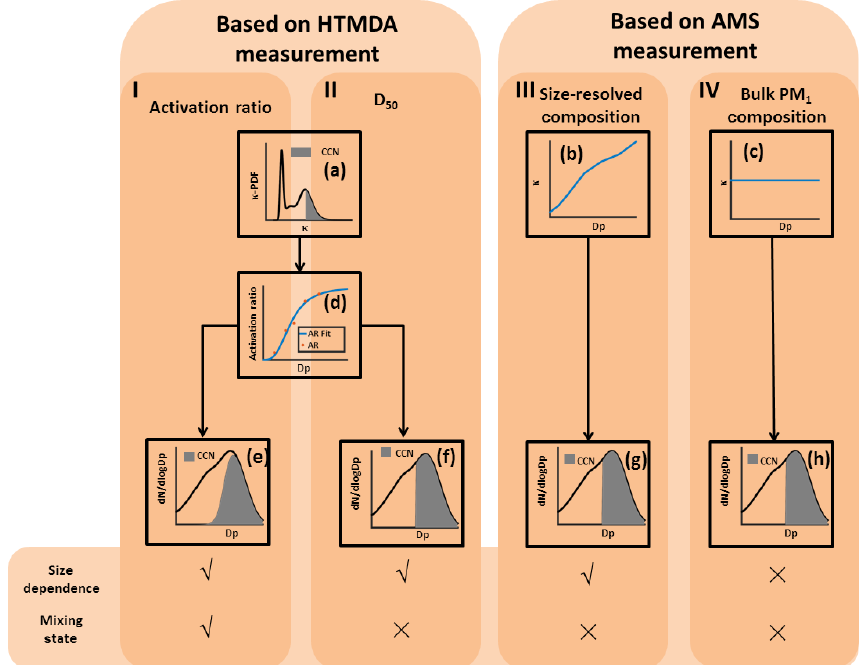
Figure 1. A schematic representation of N CCN prediction based on the HTDMA and the AMS measurements. The N CCN can be predicted based on the fitted activation ratio (approach I) and the D 50 (approach II), both obtained from the HTDMA measurement, the size-resolved composition (approach III), and the bulk PM 1 composition (approach IV), both obtained from the AMS measurements. Panel (a) shows the representation of calculating the activation ratio for a specific diameter and SS, and the shadow area represents the particles which can be activated as CCN; panels (b) and (c) show the representations of the κ values obtained, respectively, from size-resolved chemical composition and bulk chemical composition; panel (d) shows the representation of fitting the activation ratio to the particle diameter D p (red dot); panels (e) , (f) , (g) , and (h) show the representations of predicting the N CCN using the four approaches, respectively, and the shadow area represents the particles which can be activated as